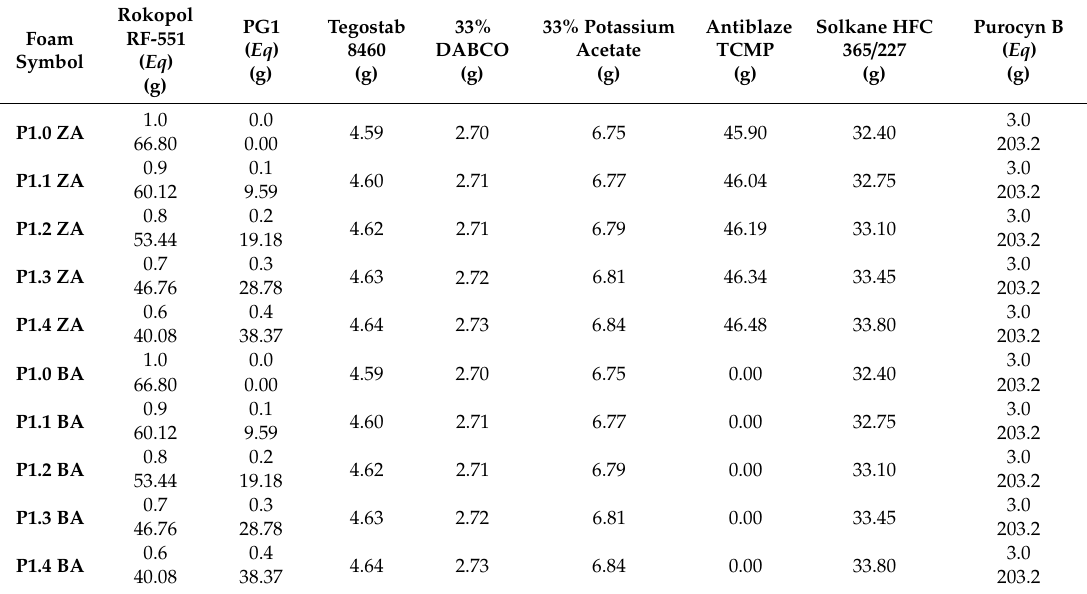
Table 1. Formulation of rigid polyurethane–polyisocyanurate (RPU / PIR) foams. Foam